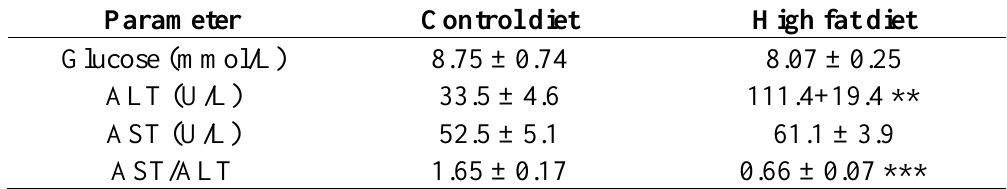
Table 1. Plasma glucose, alanine aminotransferase (ALT) and aspartate animotransferase (AST) levels in rats fed a standard low fat (Control diet) or a high fat diet for 18 weeks. Blood samples were collected and the concentration of glucose and the activity of ALT and AST was measured. Data are the mean ± SEM from 6 (Control diet) or 9 (High fat